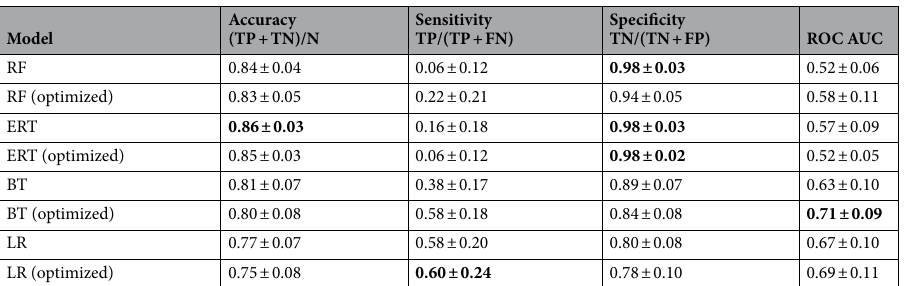
Table 2. Classification results. TP = true positive, TN = true negative, FP = false positive and FN = false negative. The results of classification are reported in the form mean ± standard deviation of the parameters obtained by 10 cross validations. All the methods report an accuracy above 75%. Specificity also is always above 75%, with two of the considered methods over the 98%, while the best performance in terms of sensitivity is 60%. Then, the Area Under the Curve and the Receiver Operating Characteristics are reported to estimate the performance in terms of accurate classification of the proposed methodology. For all results, the best-obtained scores are highlighted in bold. For the ROC AUC score, two methods (BT & LR) report better results, showing that such models have a good predictive power even though the data set is unbalanced. As expected, all the optimized models report the highest ROC AUC value than the non-optimized values (except for the ERT), due to the hyperparameter tuning.